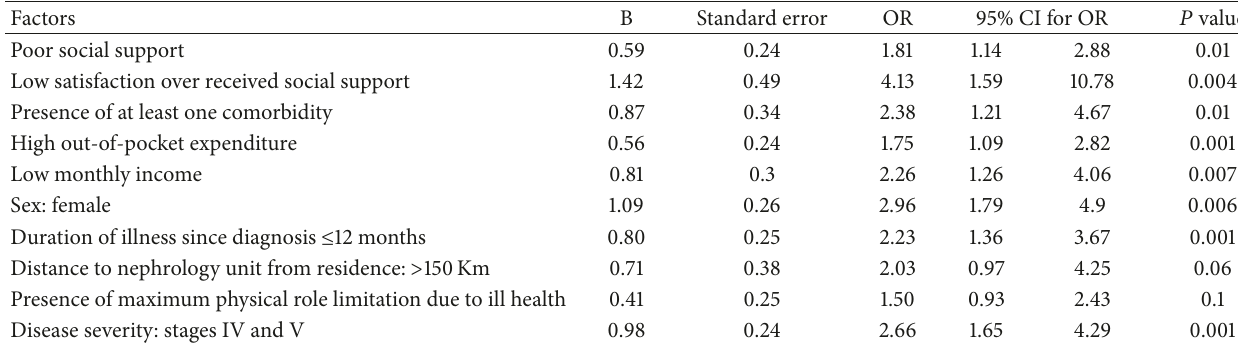
Table 4: Adjusted odds ratios of the factors associated with psychological distress of CKD